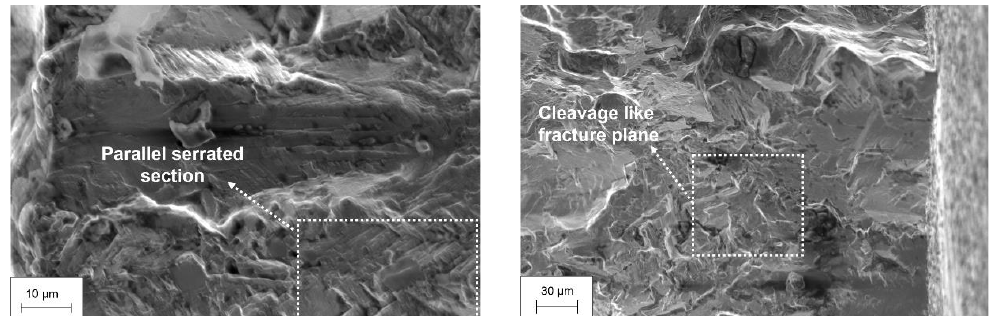
Figure 20. Fatigue crack initiation source region.